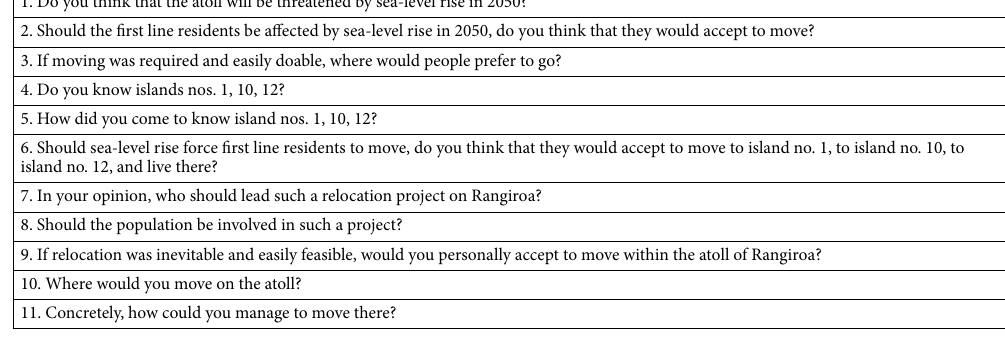
Table 1. Interview guide used for the assessment of the social acceptability of internal